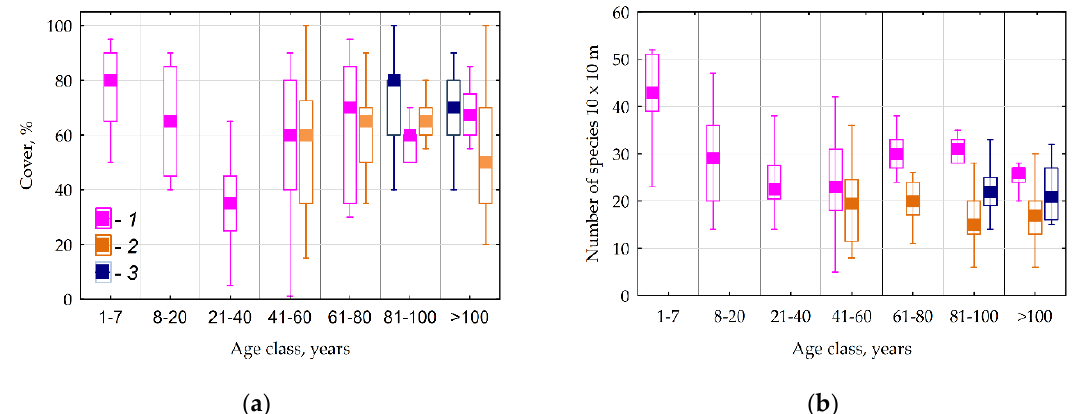
Figure 2. ( a ) Box plot of ground layer cover in plantations of different ages, ( b ) box plot of species diversity of ground layer in plantations of different ages; 1— spruce plantations; 2— pine plantations; 3— native spruce forests. Box-whisker type: median/25 and 75 percentiles/nonoutlier range.